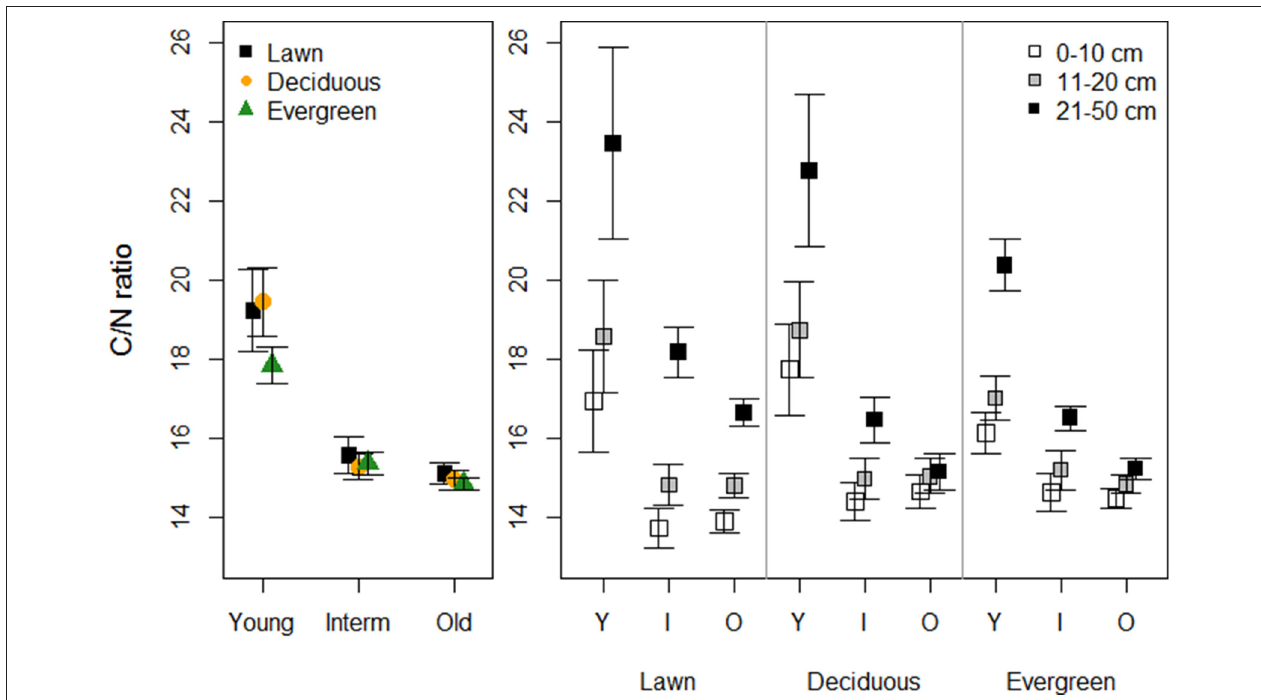
FIGURE 4 | The effects of plant functional groups and park age on the C/N ratio. Predicted means ± SE values are presented. The panel on the left presents data with the three depth intervals pooled, while in the right panel data are shown for each depth interval